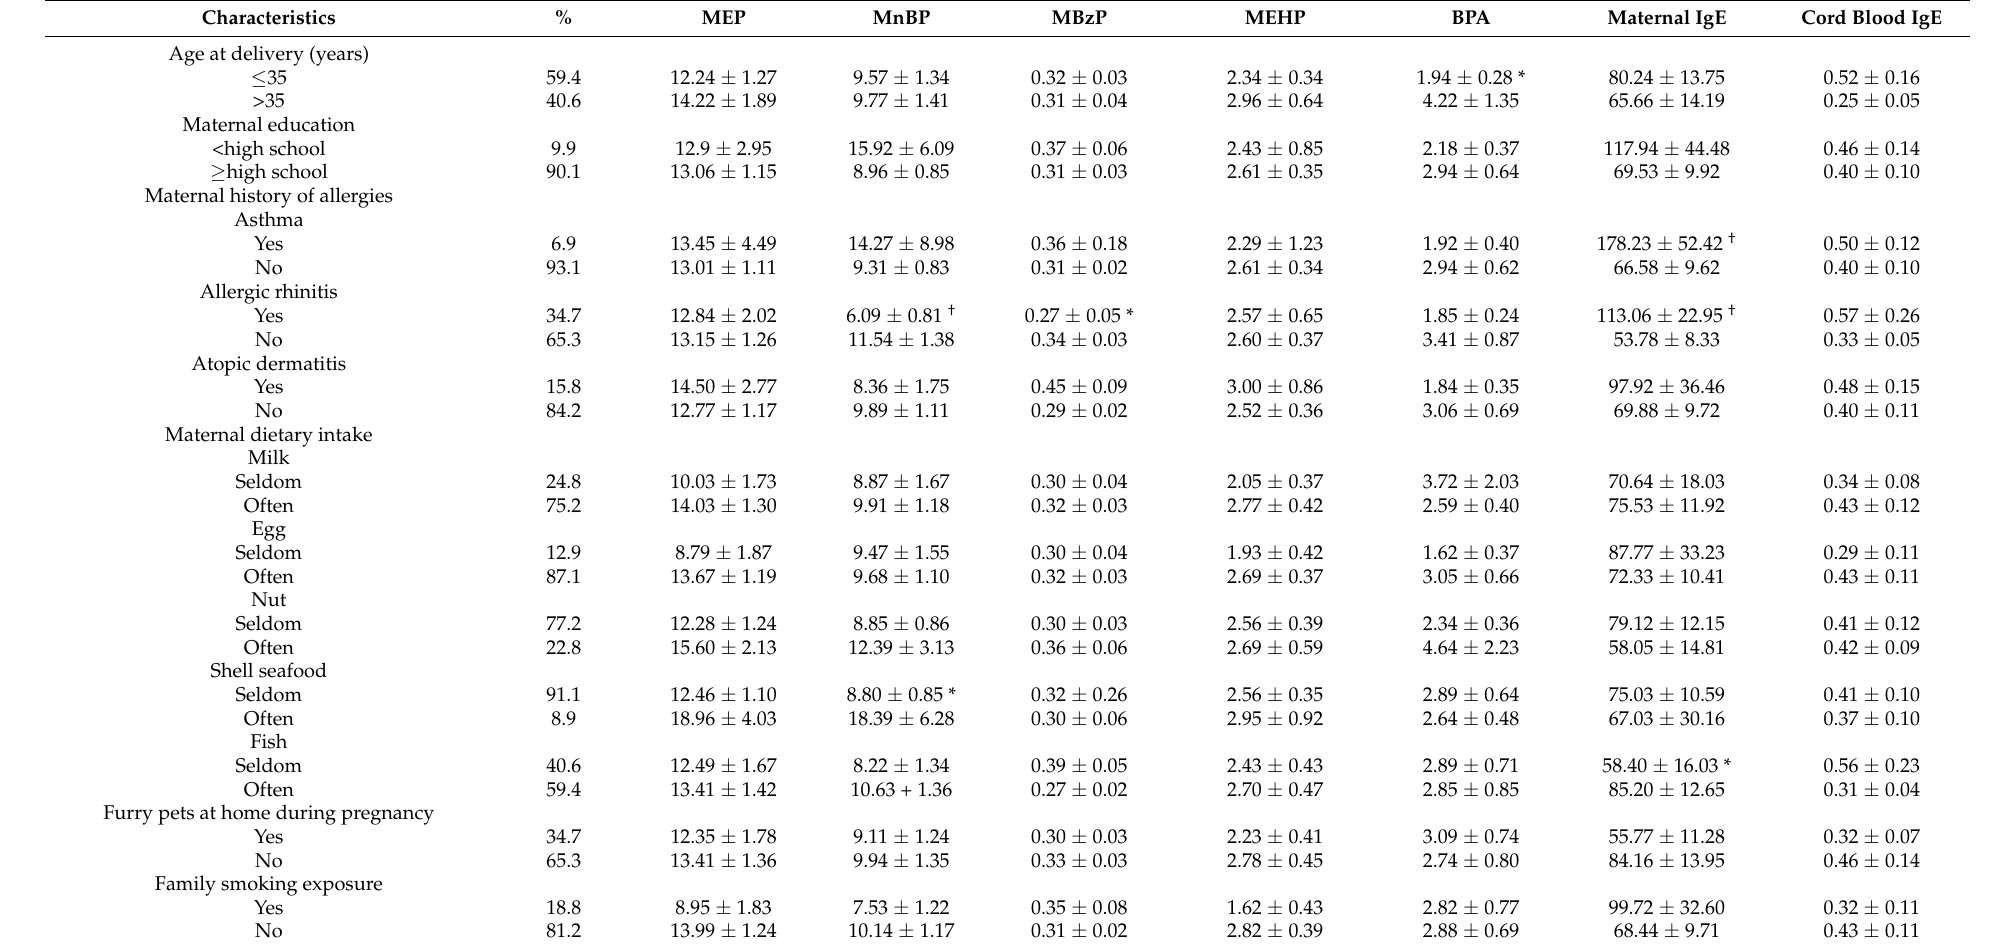
Table 3. Correlations among maternal phthalate metabolites, maternal IgE, maternal characteristics, and cord blood IgE.